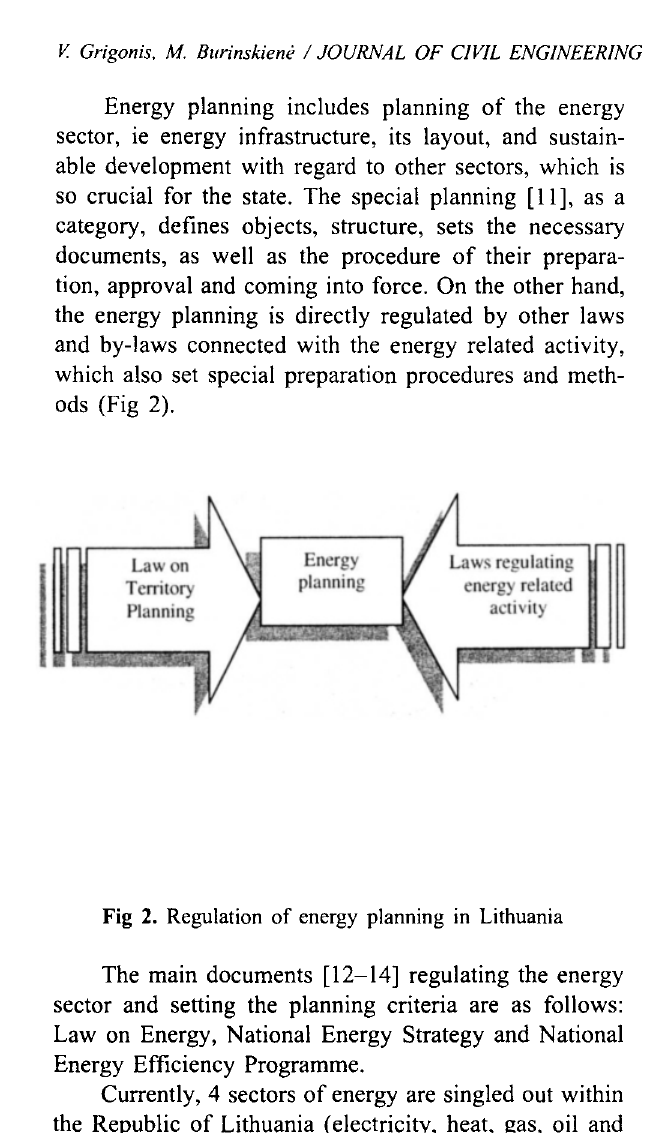
Fig 3. Consumption of the final energy (according to con sumer groups in